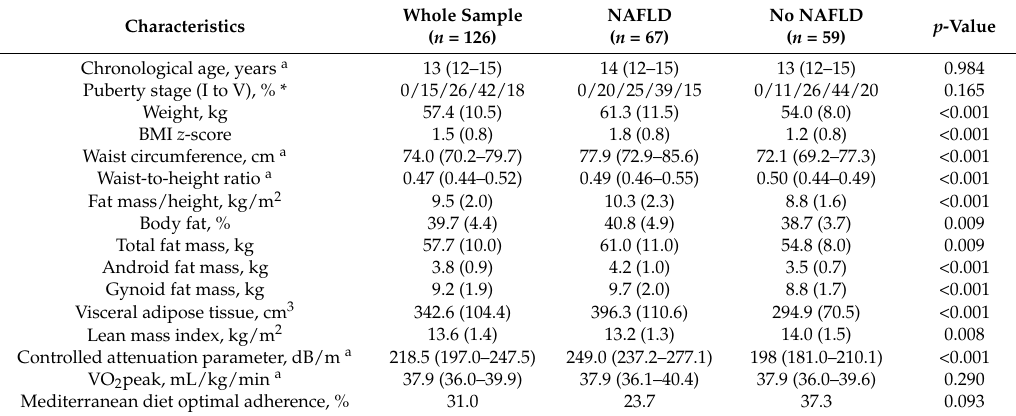
Table 1. Descriptive characteristics of participants in the